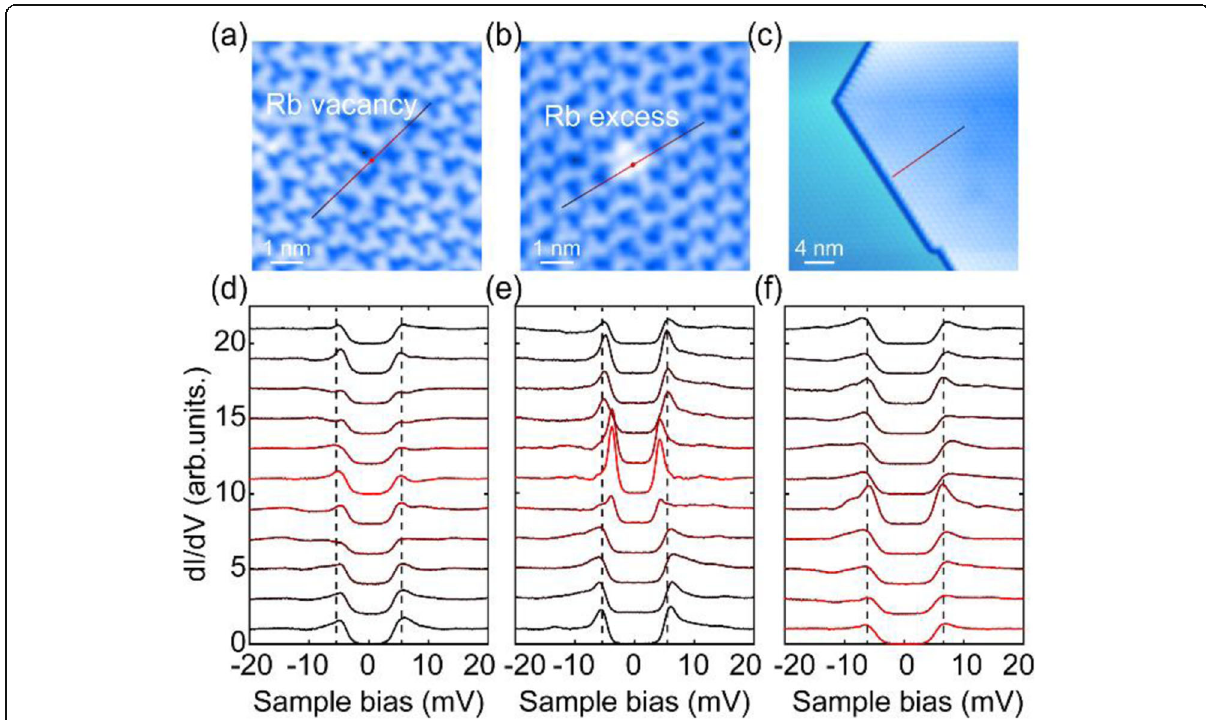
Fig. 11 ( a - c ) STM topographies of a Rb vacancy, Rb excess, and step edge. ( d - f ) d I /d V spectra taken along the colored line in ( a - c ), respectively. Taken from ref. [46]